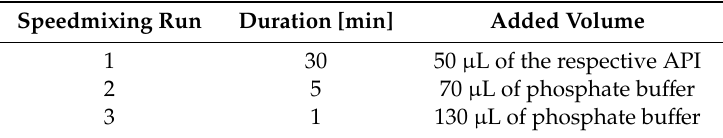
Table 3. Preparation of liposomes by the speedmixing